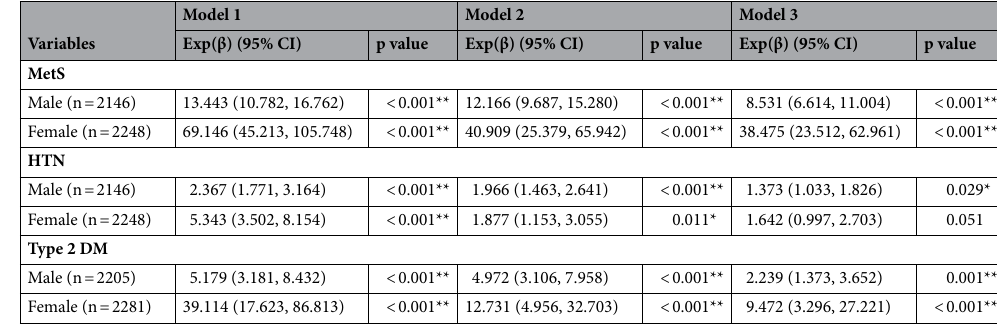
Table 2. Multivariate hazard ratios of future metabolic syndrome, hypertension and type 2 diabetes mellitus by AIP according to sex. Adjusted covariates: Model 1 = Unadjusted. Model 2 = Model 1 + age, sex and body mass index (BMI). Model 3 = Model 2 + CREA (creatinine), SBP (systolic blood pressure), FPG (fasting plasma glucose). AIP atherogenic index of plasma, MetS metabolic syndrome, HTN hypertension, DM diabetes mellitus. *p < 0.05, **p < 0.01.